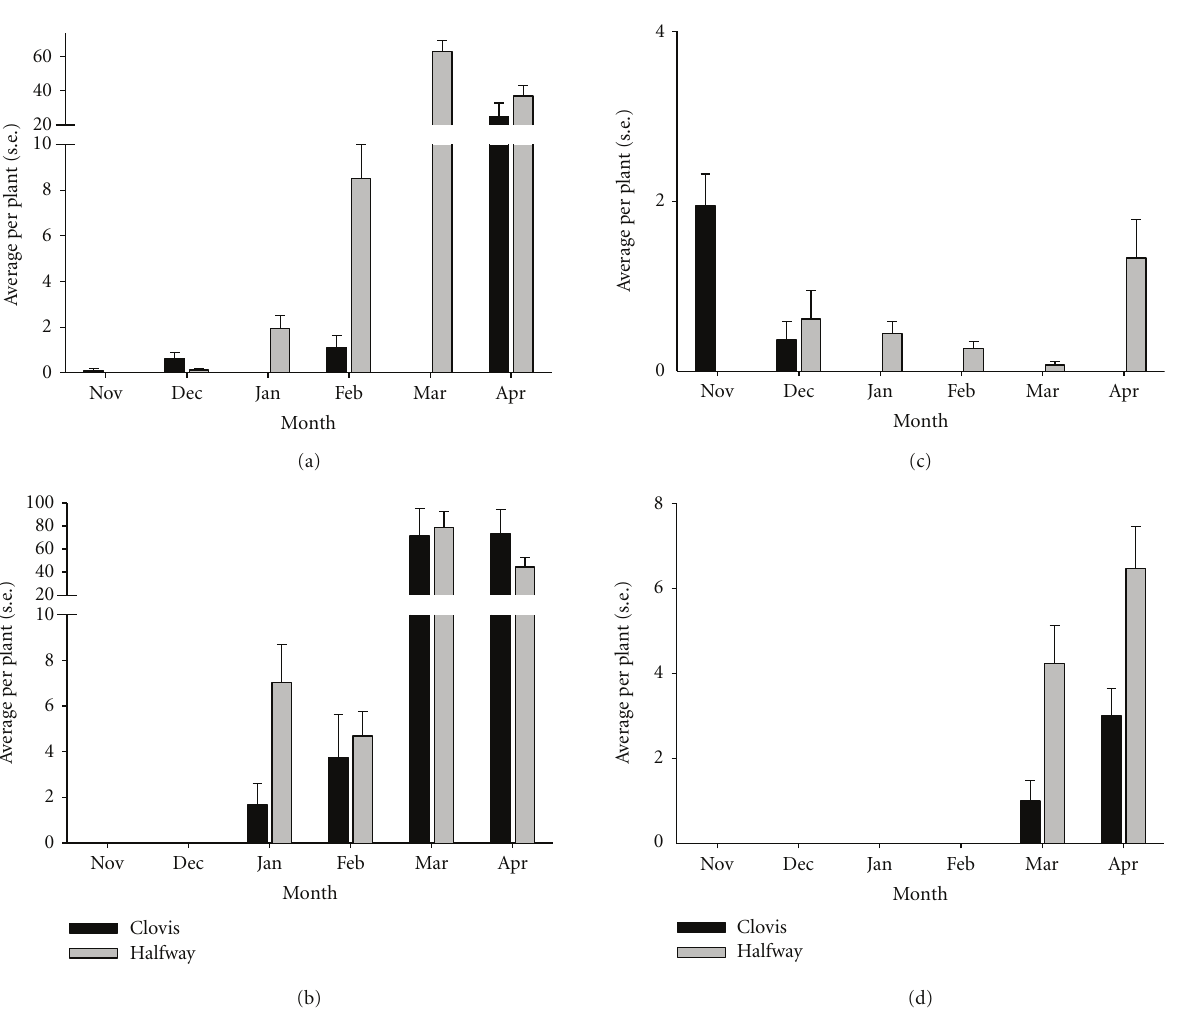
Figure 3: Seasonal dynamics of insect pests on canola plants. We assessed average density of aphids ((a) and (b)) and thrips ((c) and (d)) on canola plants during growing season 1 (2007-2008) ((a) and (c)) and growing season 2 (2008-2009) ((b) and